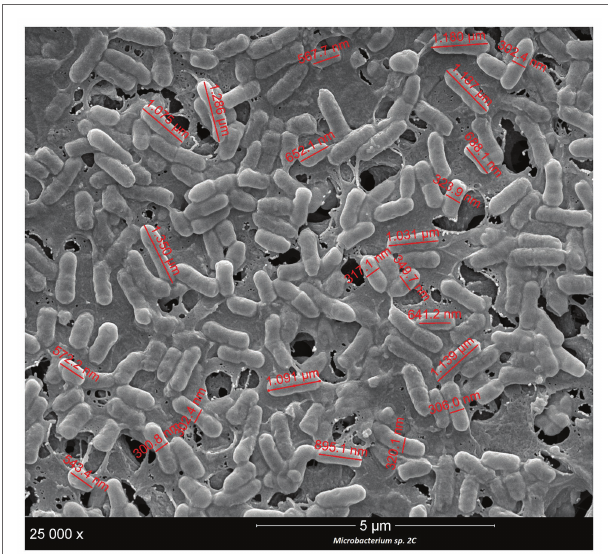
FIGURE 4 | Size and cell measurement of Microbacterium sp. 2C by SEM